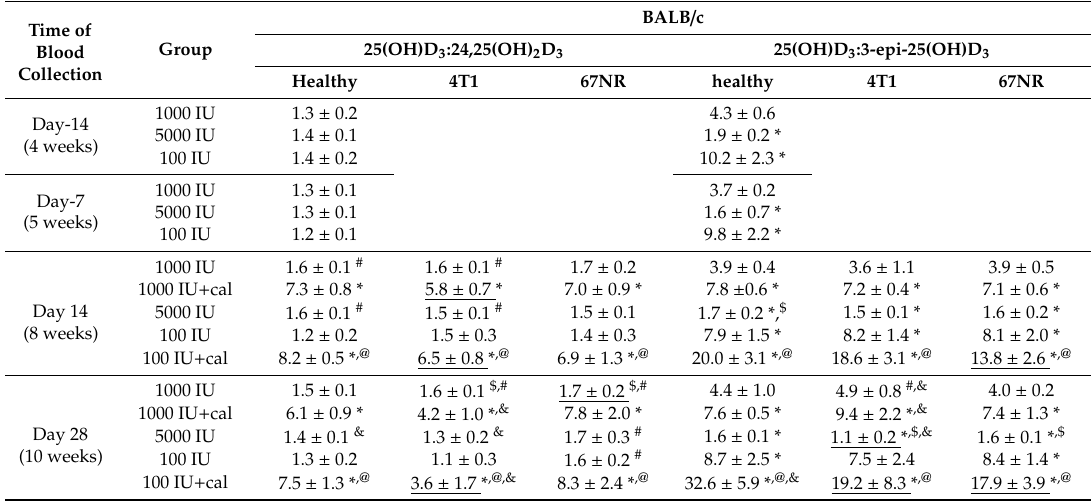
Table 2. Ratio of 25(OH)D 3 to 24,25(OH) 2 D 3 and to 3-epi-25(OH)D 3 in BALB / c mice. Time of Blood